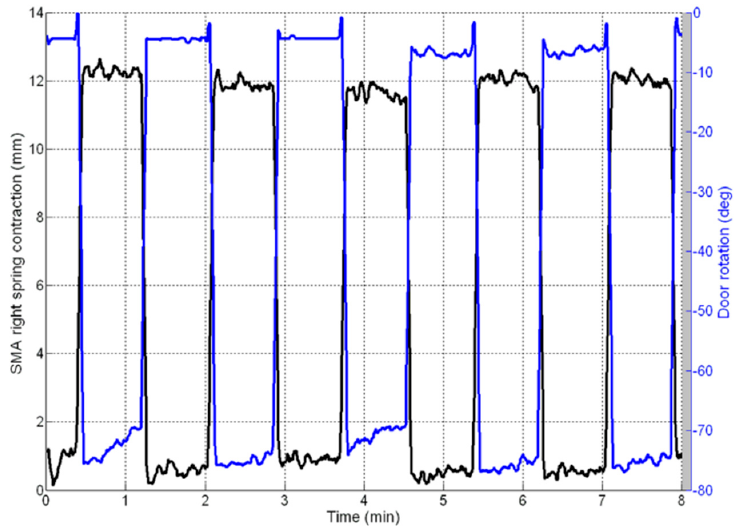
Figure 17. Five activation cycles: right spring contraction (black) vs. door rotation (blue) vs. time.